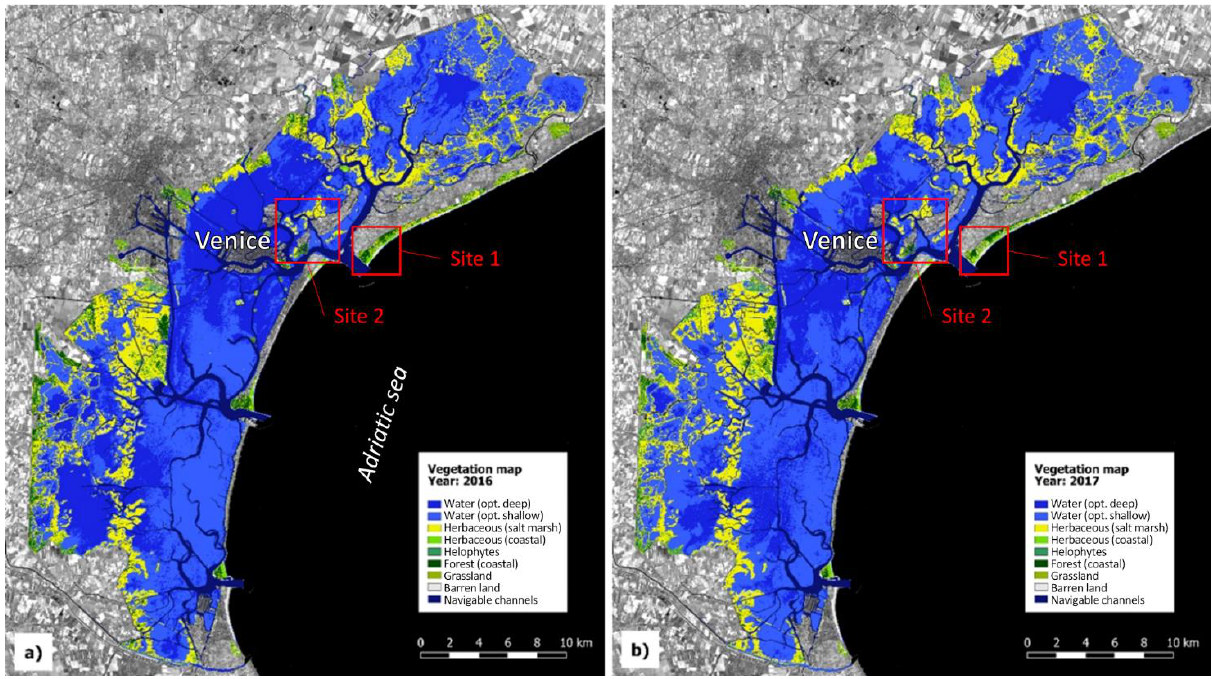
Figure 1 . Vegetation community type maps derived from Sentinel-2 time series using the integrated 2016-2017 data (test B), representing vegetation cover in Venice lagoon: a) 2016 season; b) 2017 season.